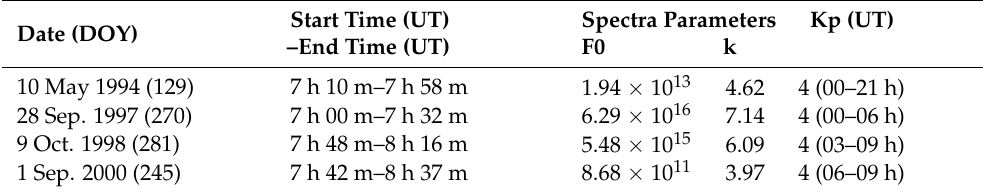
Table 1. Day of the year (DOY) and time of balloon observations, EEP spectra parameters, intensity of geomagnetic disturbances on these